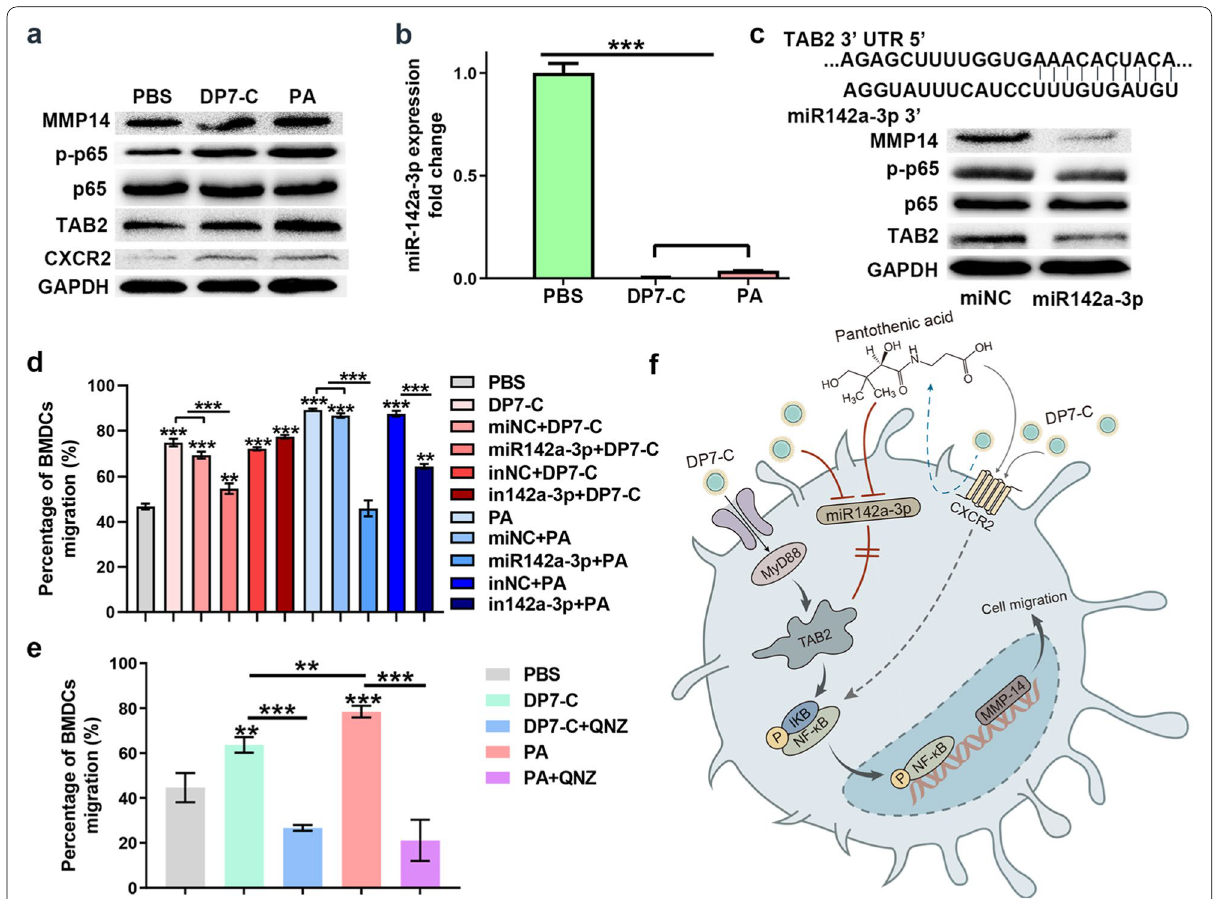
Fig. 6 DP7-C and PA can promote DC migration by inhibiting miR-142a-3p, thus activating TAB2 and the NF-κB signaling pathway. a . Western blot experiments revealed that DP7-C and PA activated the expression of CXCR2, TAB2, NF-κB p-p65 and MMP14 in DCs. b . RT-PCR revealed that the expression of miR-142a-3p in DCs was significantly inhibited after DP7-C and PA treatment. c . Western blot experiments revealed that pretransfection of cell with miR-142a-3p inhibited the expression of TAB2, NF-κB p-p65 and MMP14. d . Transwell experiments revealed that pretransfection of cells with miR-142a-3p inhibited DP7-C and PA-mediated cell migration in vitro. e . Western blot experiments revealed that pretreatment of cells with NF-κB inhibitor (QNZ) in vitro inhibited DP7-C- and PA-mediated cell migration. f . Proposal of mechanism by which DP7-C promotes DC migration. Significance was calculated using a one-way ANOVA with multiple comparisons tests (* p < 0.05, ** p < 0.01, *** p <